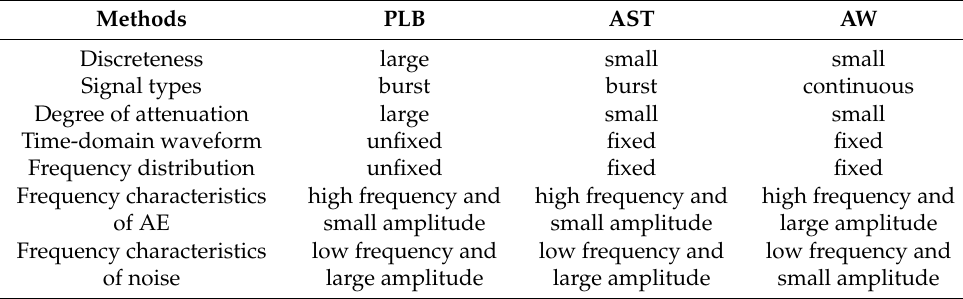
Table 4. Comparison results of three wave velocity measurement